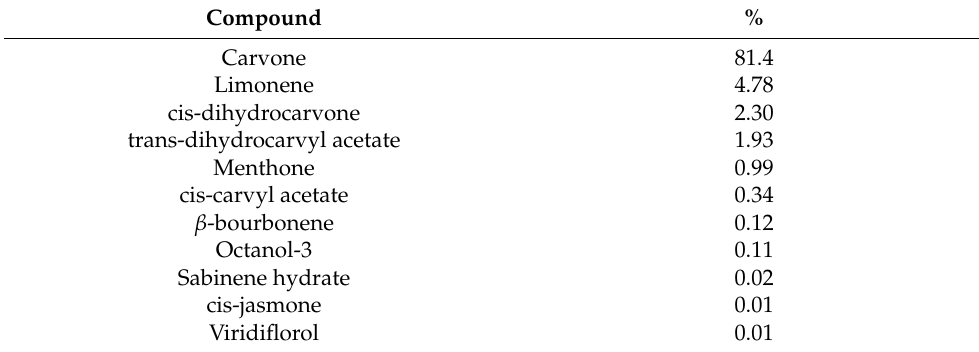
Table 1. Spearmint essential oil